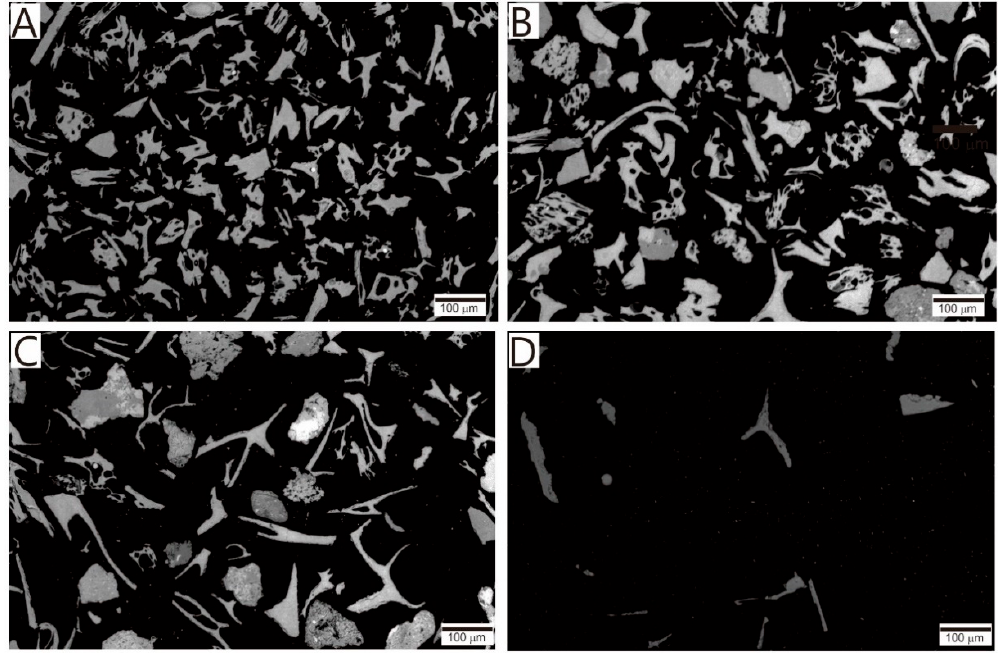
Figure 5. Backscattered electron images of tephra samples from ODP 794A core in the Japan Basin of the East Sea/Japan Sea. ( A ): Toya, ( B ): B-KY1, ( C ): Aso-1, and ( D ): Aso-4.